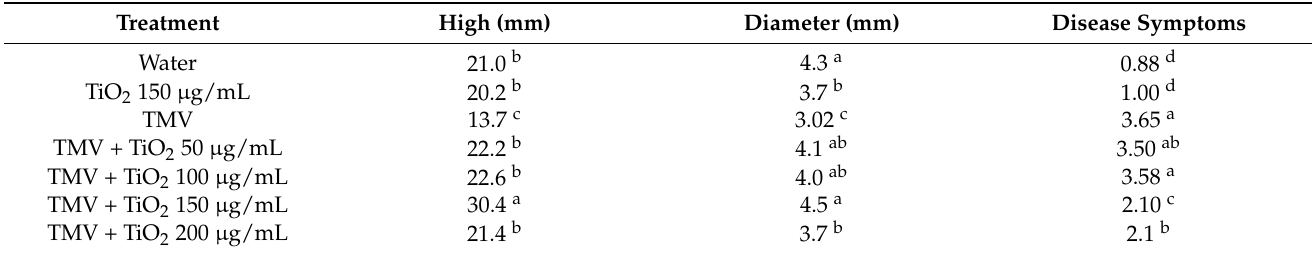
Table 2. Morphological characteristics and symptom level in plants infected with TMV and treated with TiO 2 NPs.